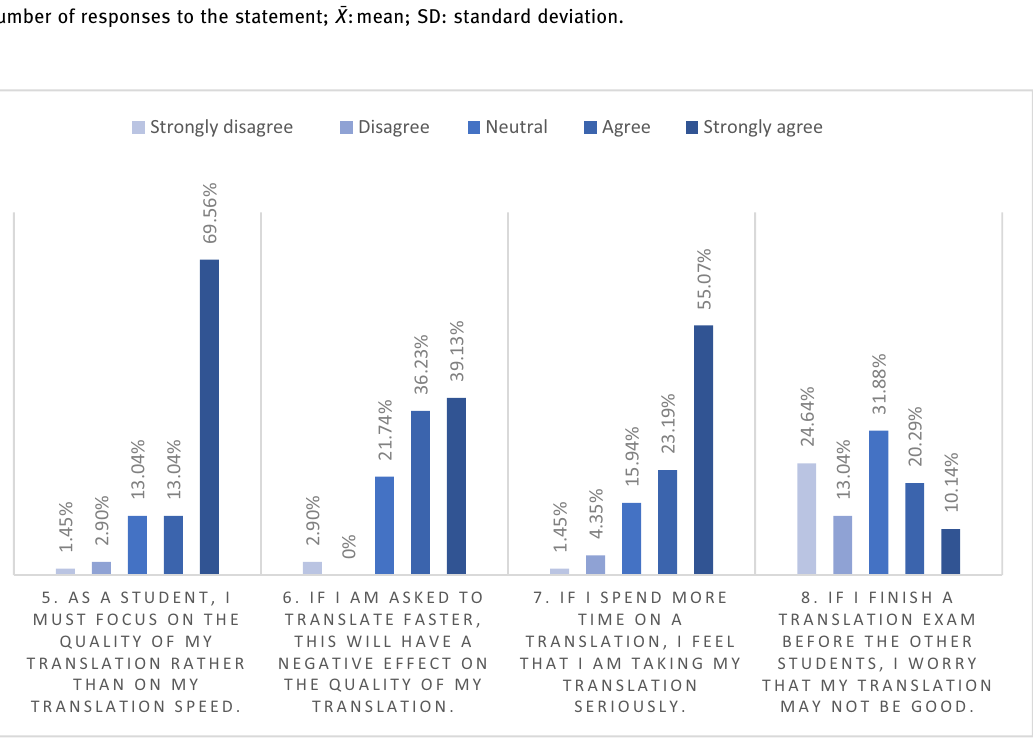
Figure 2: Speed and the perception of quality. This fi gure provides the summary of responses to statements on the relation between speed in translation and the criterion of